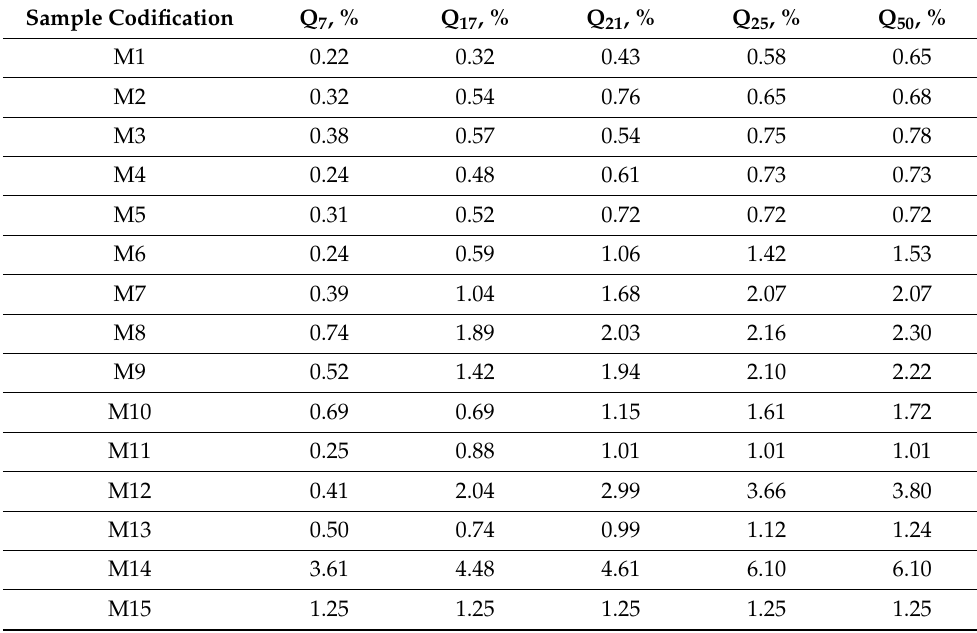
Table 3. The swelling degree percentage at different time-points.